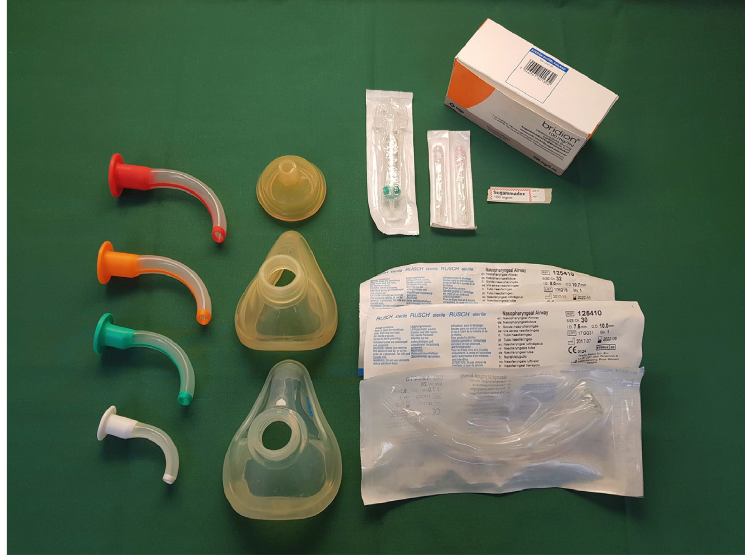
Figure 4: Drawer 3 (plan C) mask ventilation.